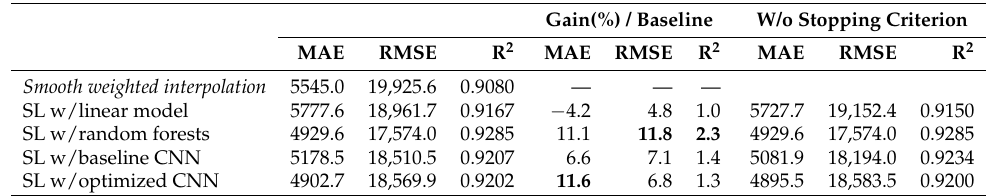
Table 10. Results obtained with the self-training approach using different regression algorithms for the amount of national withdrawals during the summer months. Gain(%) / Baseline W/o Stopping Criterion MAE RMSE R 2 MAE RMSE R 2 MAE RMSE R 2 Smooth weighted interpolation 5545.0 19,925.6 0.9080 — — — SL w/linear model